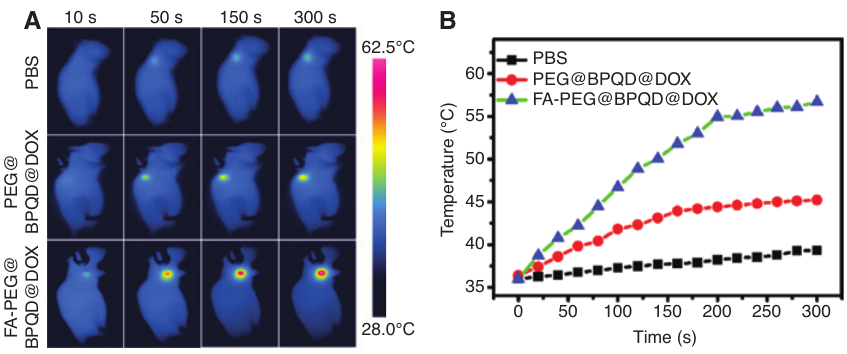
Figure 5: In vivo photothermal effects of FA-PEG@BPQD@DOX. (A) The thermal images of mice with 293T tumors irradiated at 808 nm (2 W/cm 2 ). These mice were injected with PBS, PEG@BPQD@DOX, or FA- PEG@BPQD@DOX. (B) The temperature of mice irradiated at 808 nm (2 W/cm 2